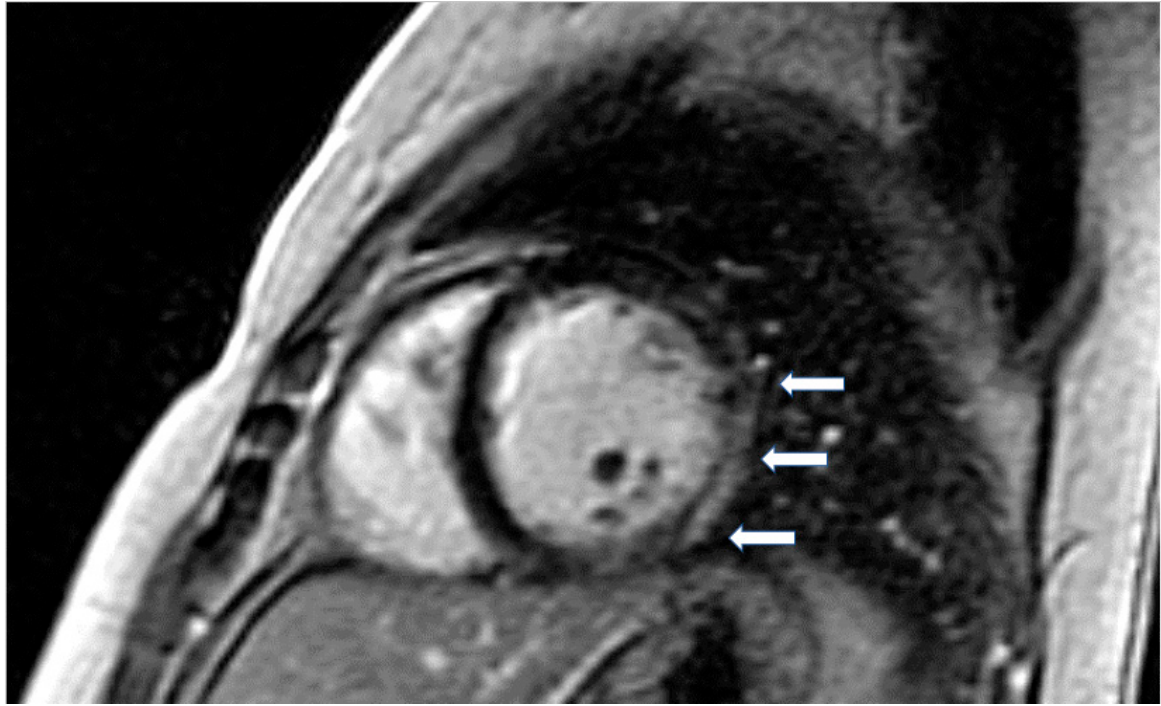
Figure 3. Short axis LGE image showing diffuse subendocardial fibrosis (arrows) in a patient with Churg–Strauss vasculitis.